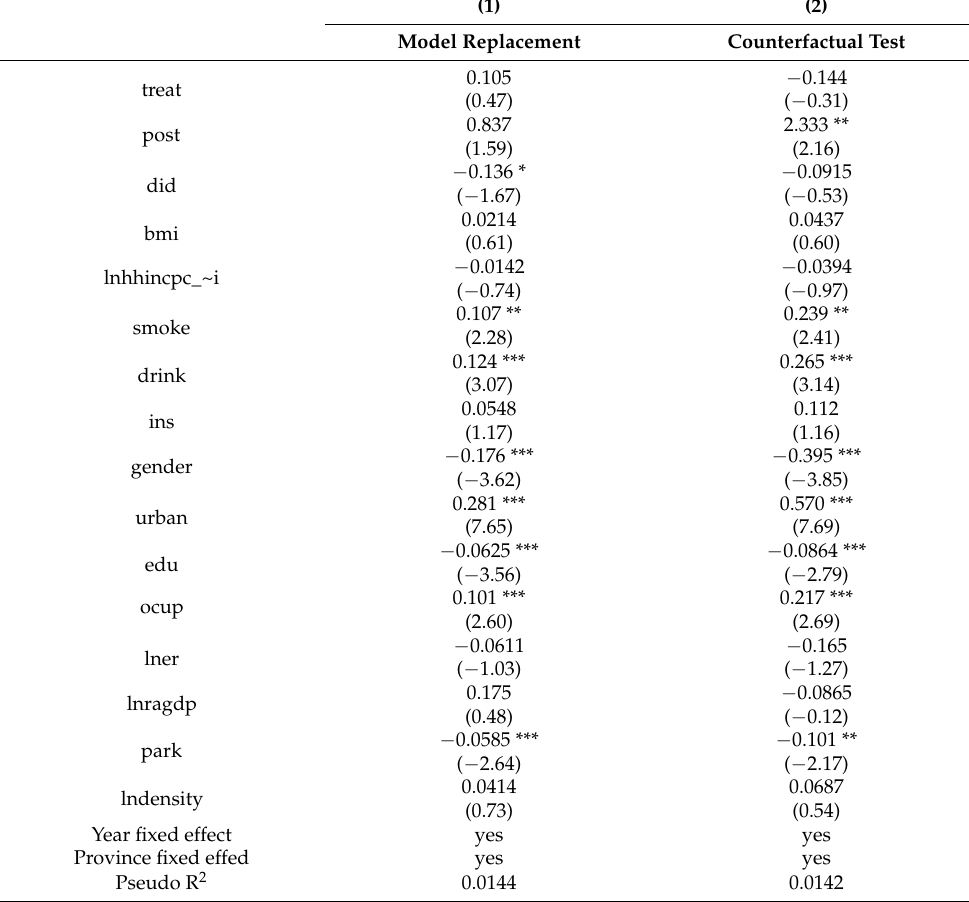
Table 6. Robustness check